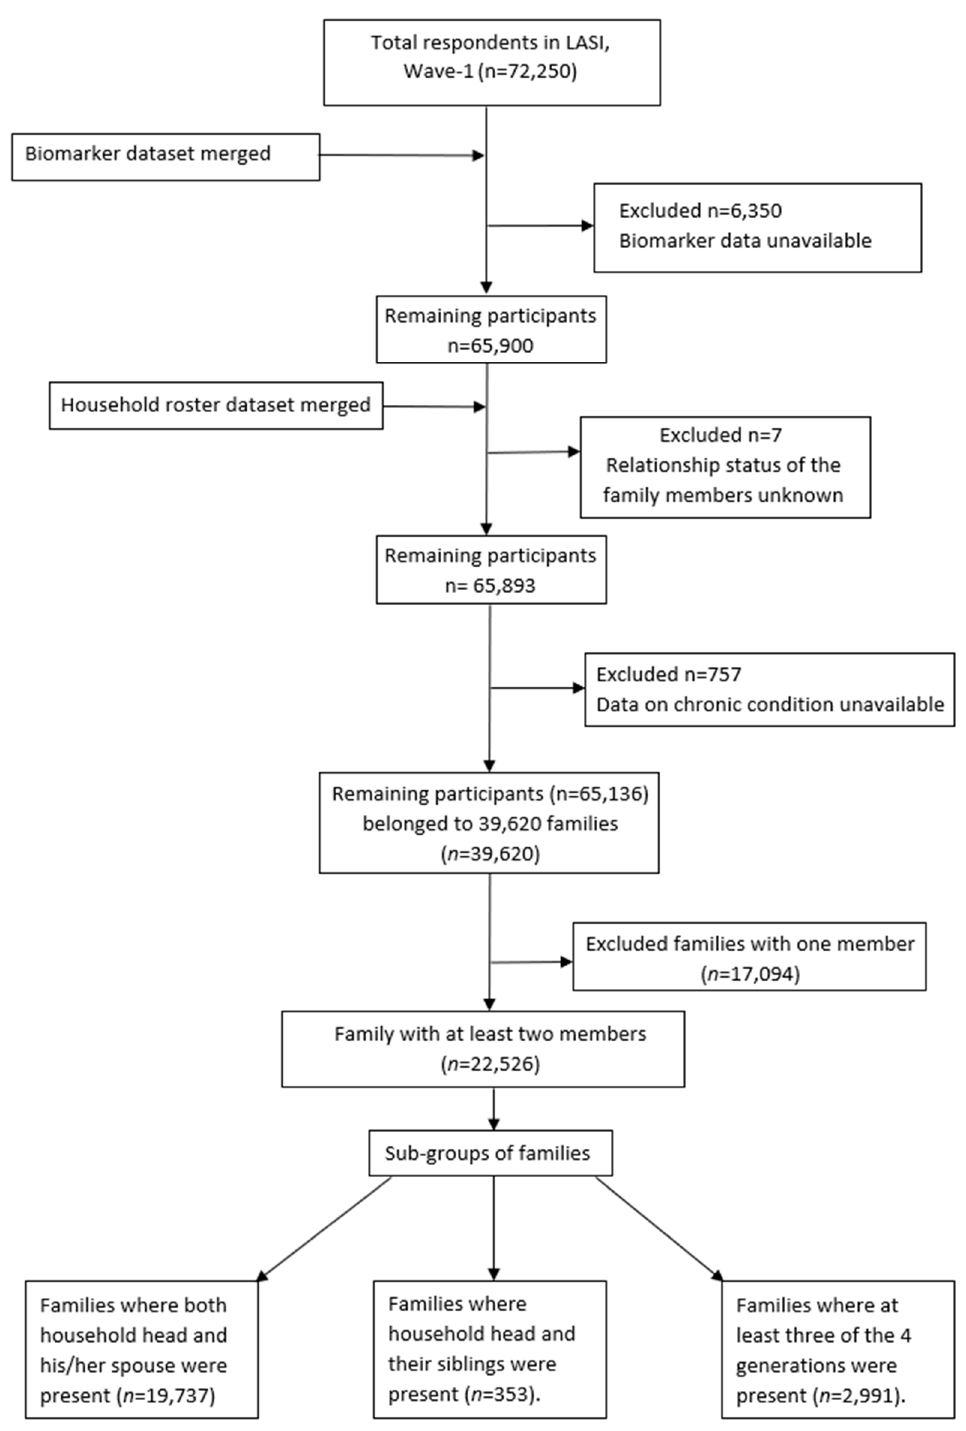
Figure 1. Selection of study participants. LASI compiled data into three separate datasets, namely, “individual”, “biomarker”, and “household roster” datasets, which were merged to create various variables used in the present study.